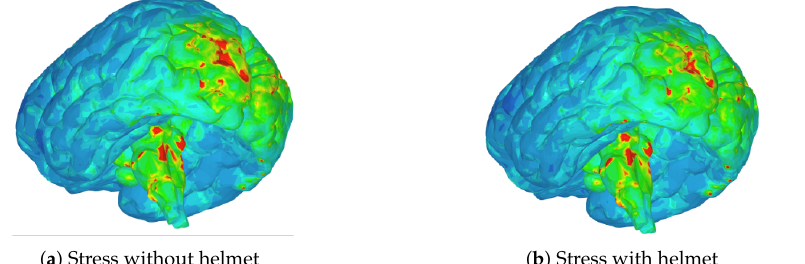
Figure 9. Stress distribution results (Scaled; blue: 0, red: max in Wave A) extracted at the peak of wave A without ( a ) and with ( b ) the